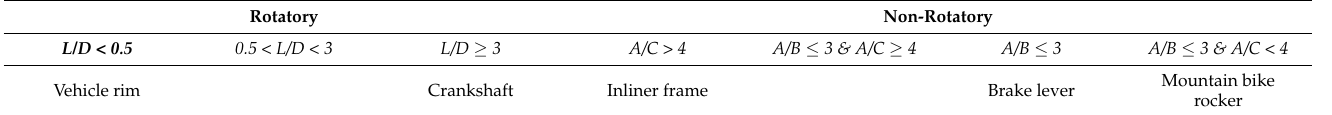
Table 1. Categorization of the simulation parts in accordance with the Opitz coding system